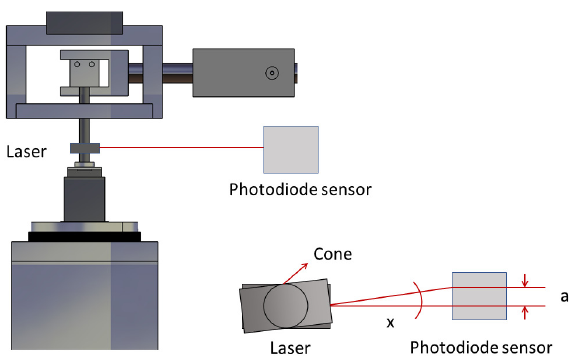
Figure 5. Deformation measurement by a laser and a photodiode